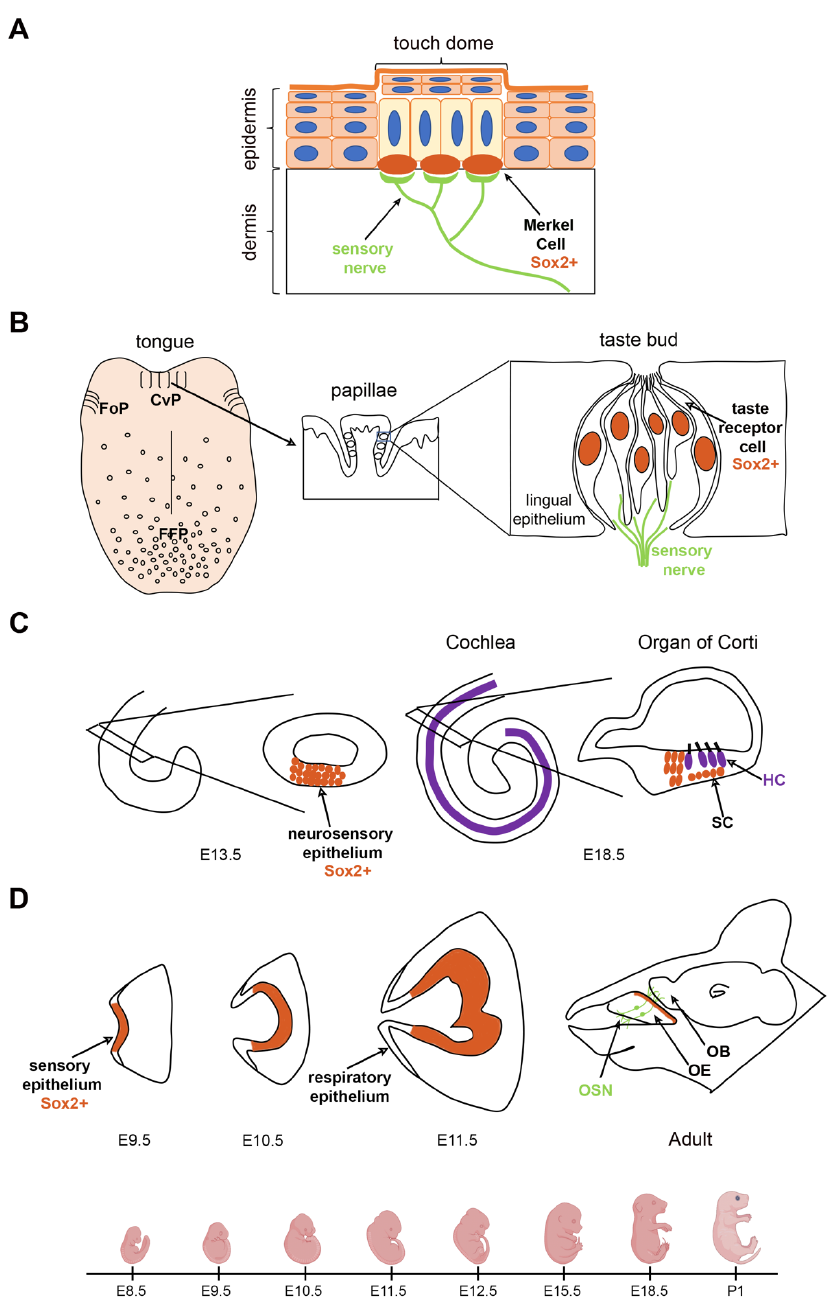
Figure 1. Sox2 expression during development of sensory organs in mice. ( A ) Schematic representation of a Merkel cell–neurite complex on the skin. Sox2 -expressing Merkel cells are indicated. ( B ) Schematic representation of the distribution of papillae on the tongue and of the organization of taste buds. Taste receptor cells expressing Sox2 are indicated. Circumvallate papillae (CvPs), foliate papillae (FoPs) and fungiform papillae (FFPs). ( C ) Schematic representation of inner ear development. Sox2 -expressing neurosensory epithelium and support cells (SCs) are indicated. Sox-negative hair cells (HCs) are shown. ( D ) Schematic representation of the olfactory system. Sox2 -expressing sensory epithelium and olfactory epithelium (OE) are indicated. Olfactory sensory neurons (OSNs) projecting to the olfactory bulb (OB) are shown. At the bottom of the figure, a timecourse of mouse development is